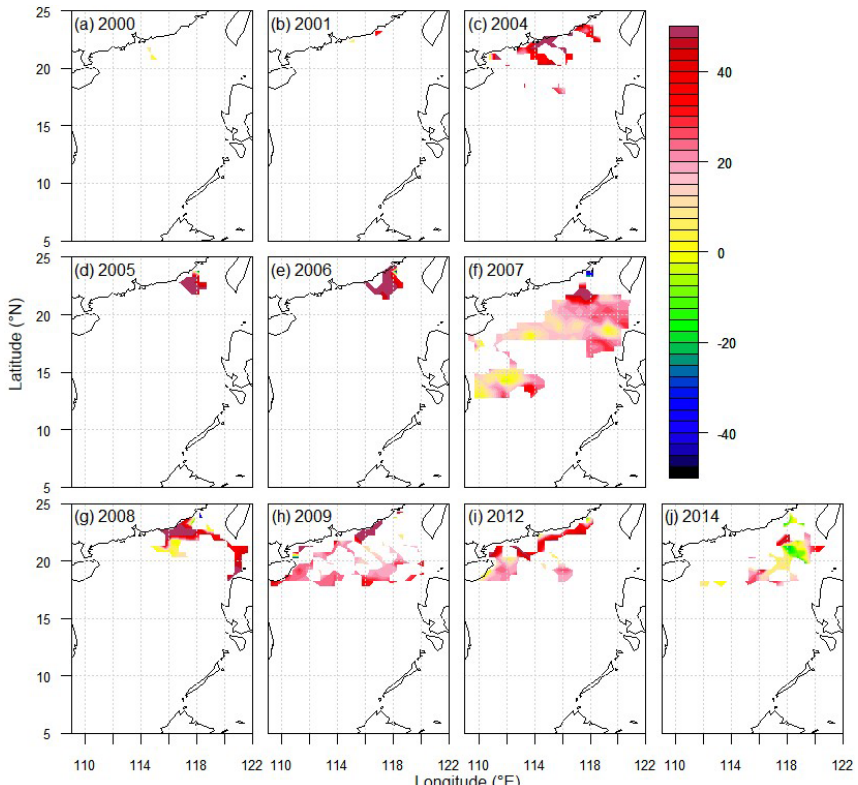
Figure 5. The difference between the remote-sensing-derived summer p CO 2 estimates and the observed underway p CO 2 (unit: µatm) in 2000, 2001, 2004–2009, 2012, and 2014.